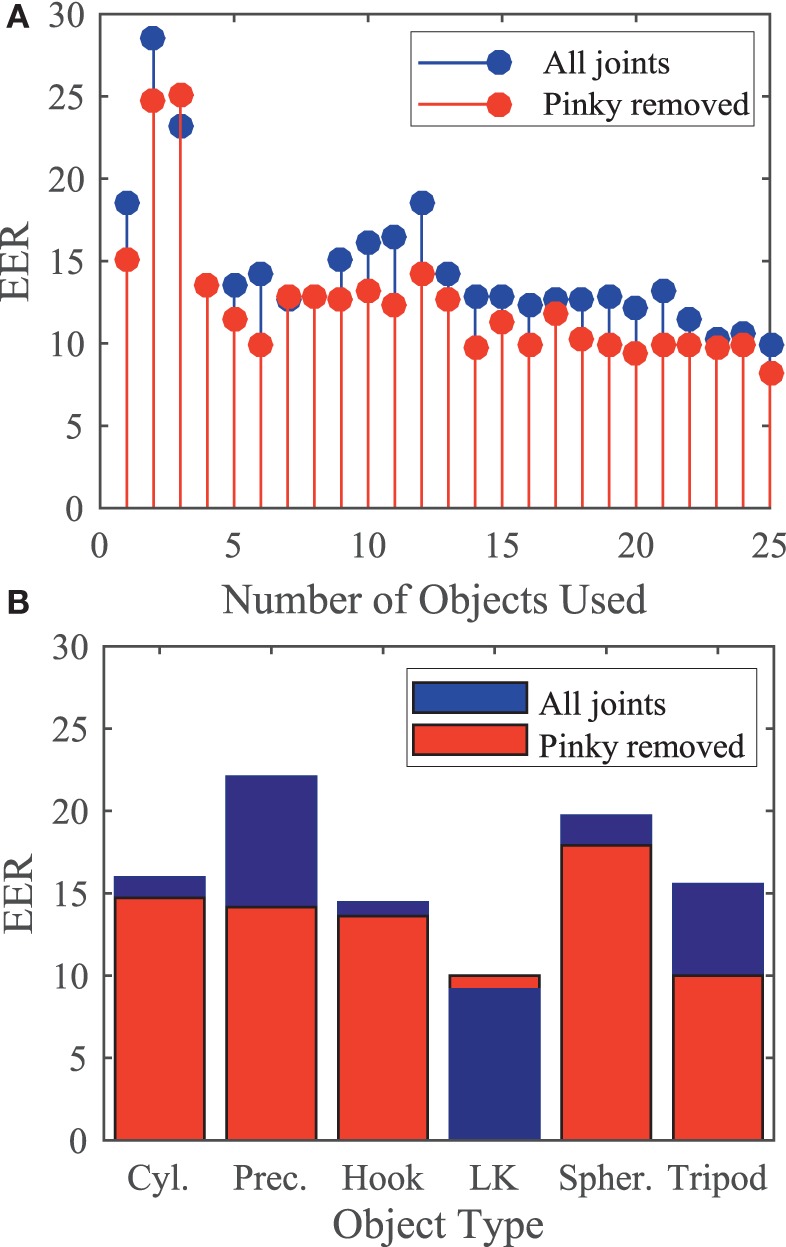
(A) Equal error rate (EER) when increasing number of objects are used. Using the first six highest ranked objects produces an EER of 10% when pinky is removed. (B) Using only five lateral key grasps produces an EER of 9.17% when the pinky is removed.